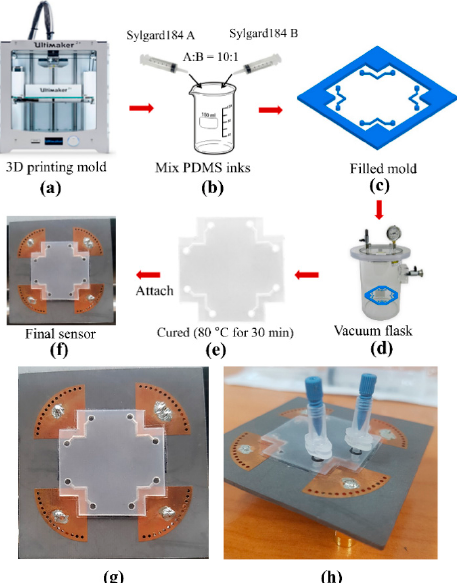
Figure 6. ( a – f ) Microfluidic channel fabrication using polydimethylsiloxane (PDMS), ( g ) fabricated 4 ‐ port quarter ‐ mode substrate ‐ integrated waveguide resonator prototype top view, and ( h ) nanoport